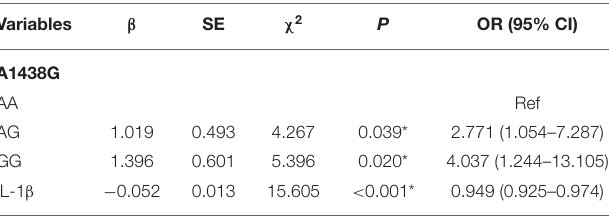
TABLE 8 | Logistic regression analysis of cytokines, 5-HTR2A polymorphisms, and sleep quality. Variables